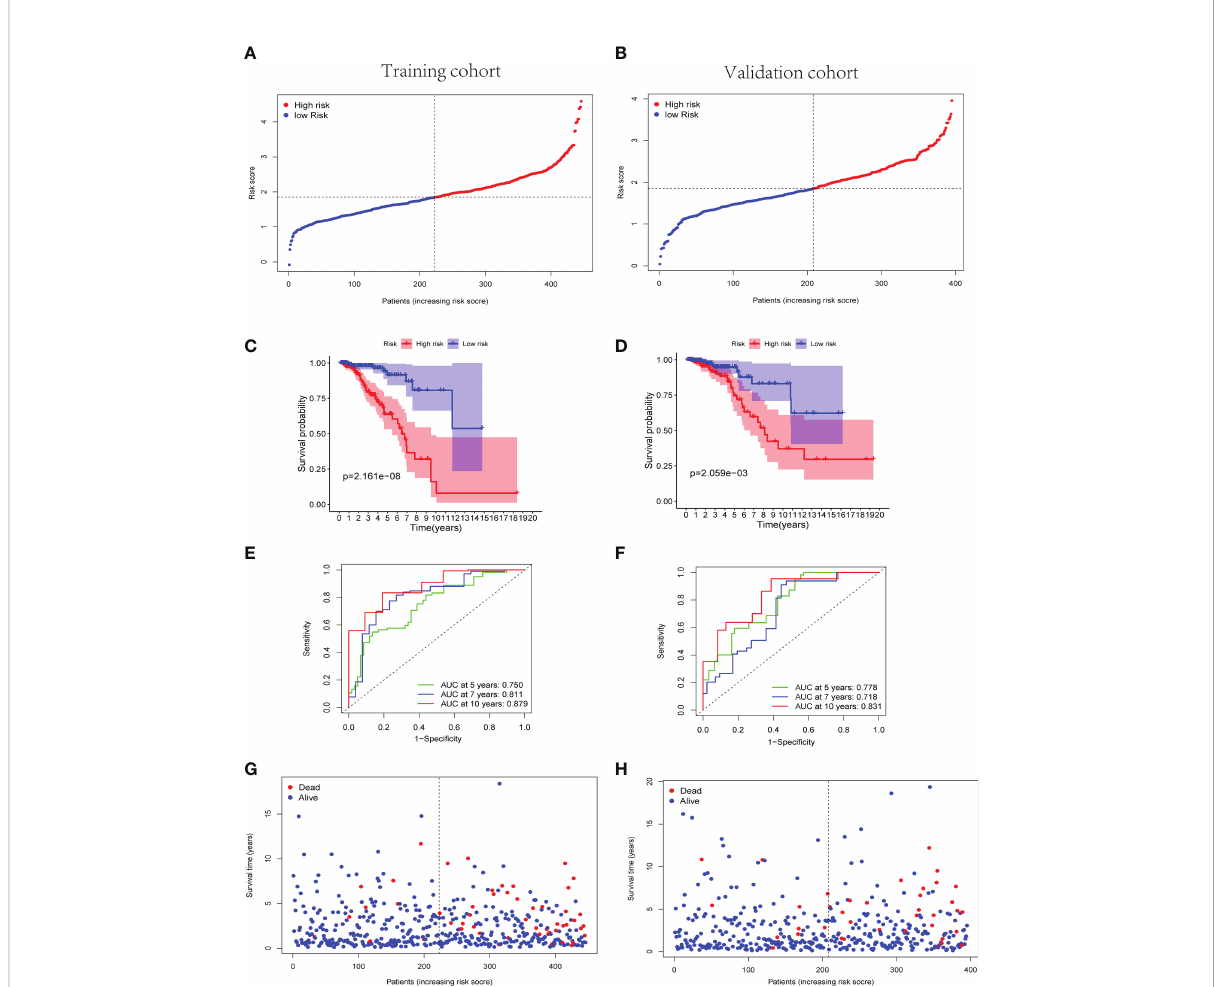
FIGURE 3 Predictive effectiveness evaluation of the cuproptosis-related lncRNA signature. (A, B) The distribution and median risk score in training group (A) and validation group (B) ; the cutoff value of high- and low- risk sets was set as the median risk score of training cohort. (C, D) Kaplan – Meier survival curves for training (C) and validation (D) groups suggested that the OS of the high-risk sets was lower than that of the low-risk sets (p = 2.161E − 08 and p = 2.059E − 03). (E, F) ROC curve analysis for the accuracy of the risk model to forecast clinical outcomes of patients with BC at 5, 7, and 10 years in training (E) and validation (F) groups. (G, H) The distributions of survival time status in training (G) and validation (H) sets. lncRNA, long non-coding RNA; OS, overall survival; ROC, receiver operating characteristic; BC, breast